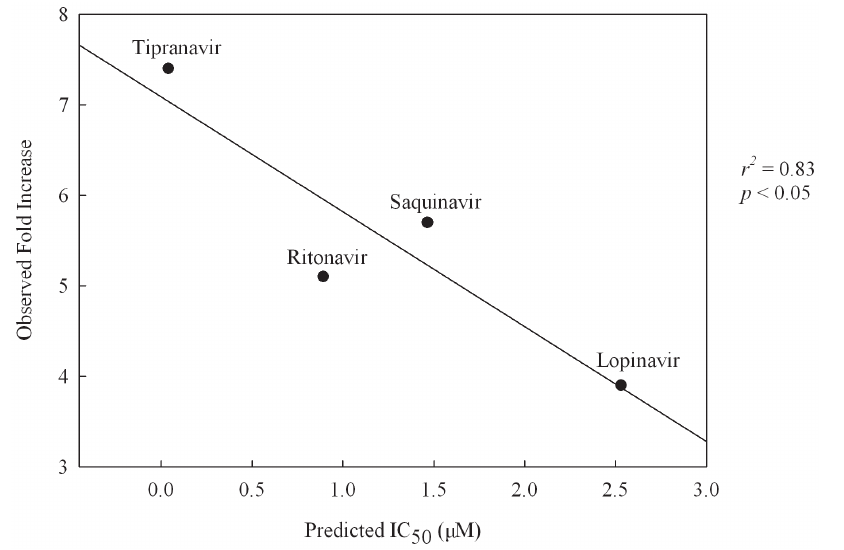
Figure 10. Observed fold increase vs . predicted IC 50 . Experimental fold increase vs . the IC 50 predicted by PhE/SVM for those HIV protease